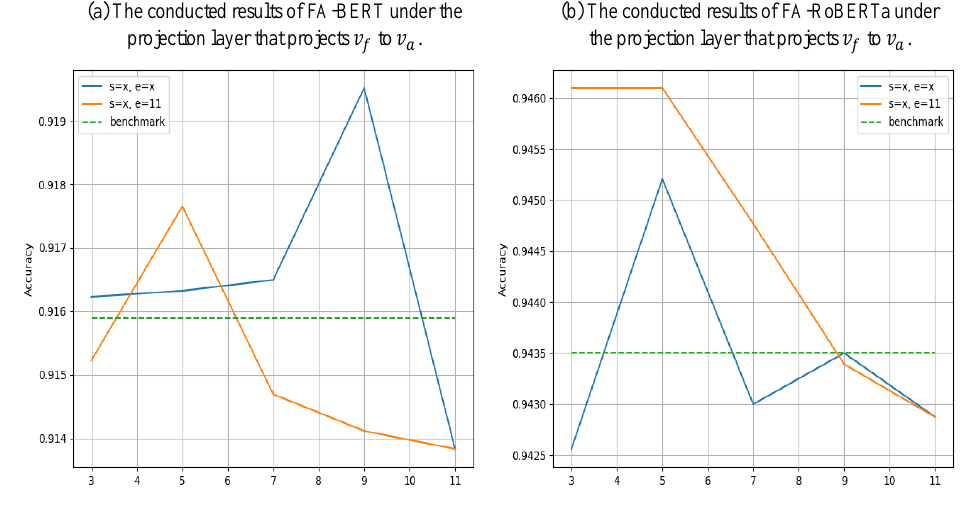
Figure 5. In this figure, we concatenate v f with v a to implement our FA-Nets. Both models are implemented in the SST2 dataset. Chart a is the BERT-based model, and chart b is the RoBERTa-based model. All results shown in this figure are averaged from the five seeds. The blue line is labeled by s = x, e = x , which means the first encoder and the last encoder in A-Net are copied from the x th encoder in F-Net. Furthermore, the orange line means the last encoder of A-Net is fixed to 11 , but the first encoder is changed with x . Moreover, the dotted green line results from corresponding benchmark